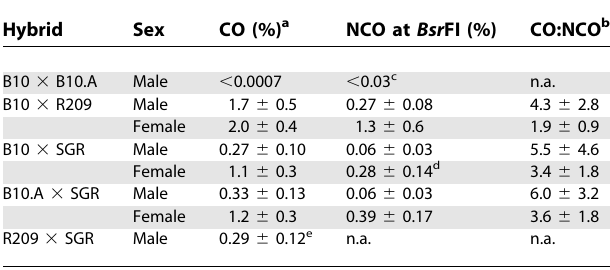
Table 1. CO and NCO Frequencies at the Psmb9 Hotspot in Various Hybrids